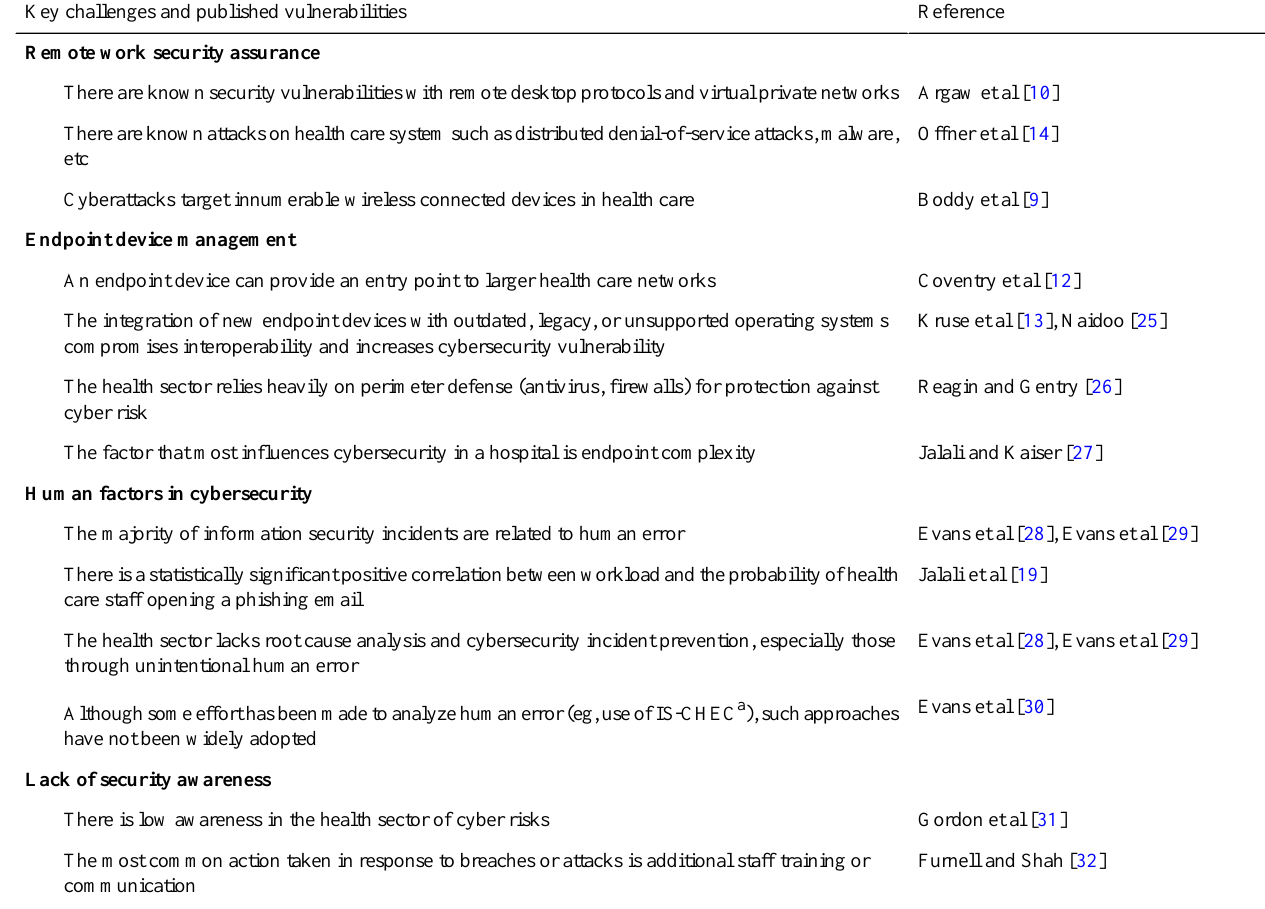
Table 3. Key health sector security challenges and associated